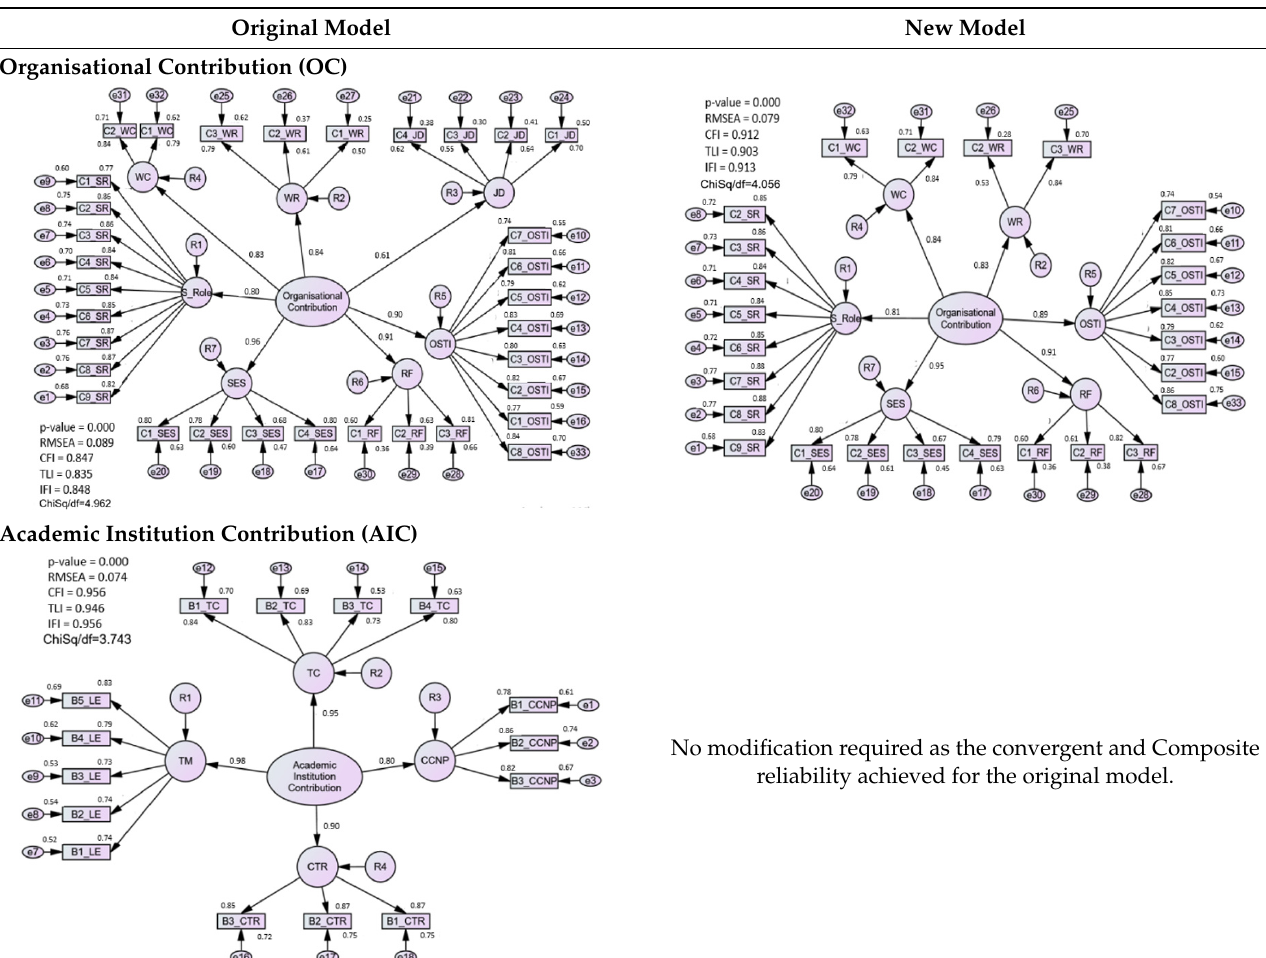
Table 1. Individual CFA of the original and new measurement models.